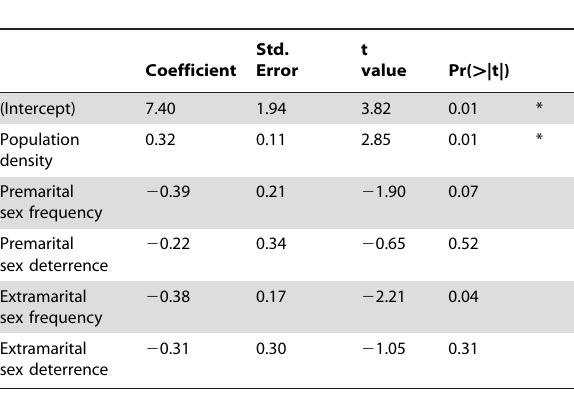
Table 1. Population size and extramarital sex.